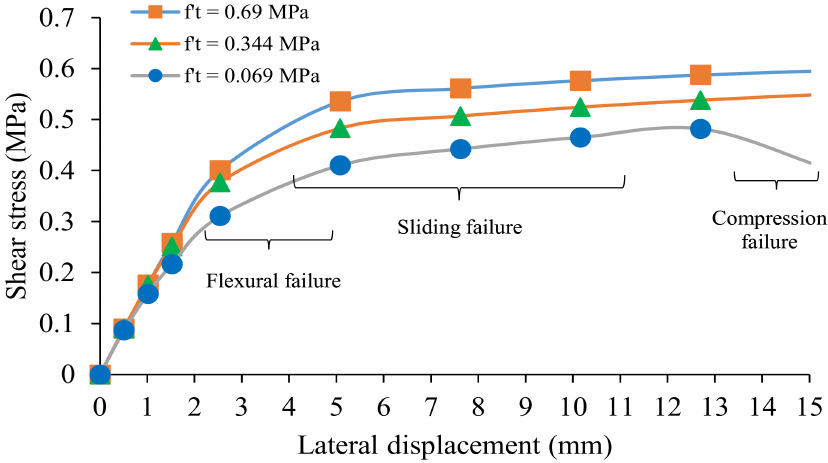
Figure 11. Influence of flexural tensile strength on shear strength of URM